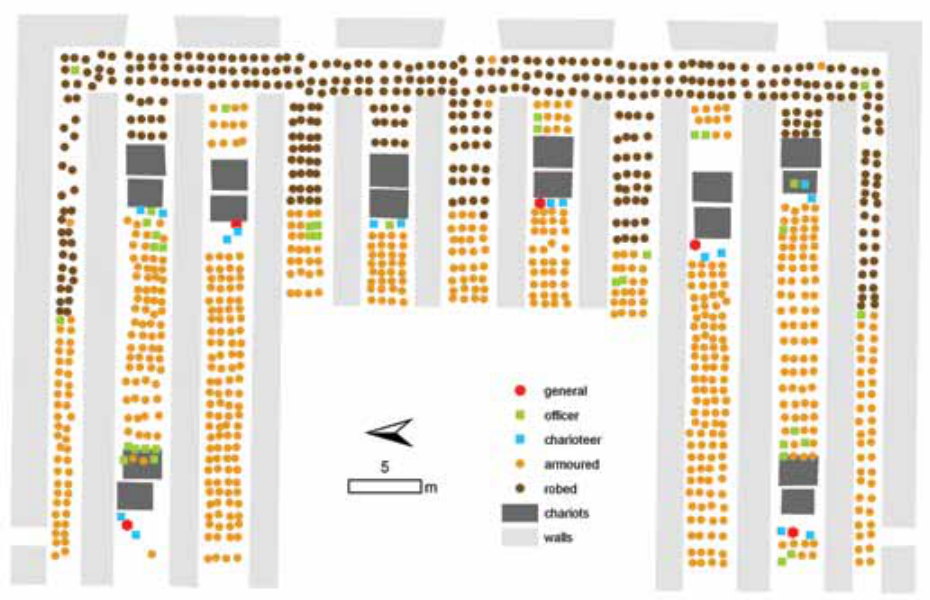
Fig. 4: Plan of the excavated area of Pit 1, showing the distribution of different warrior types.